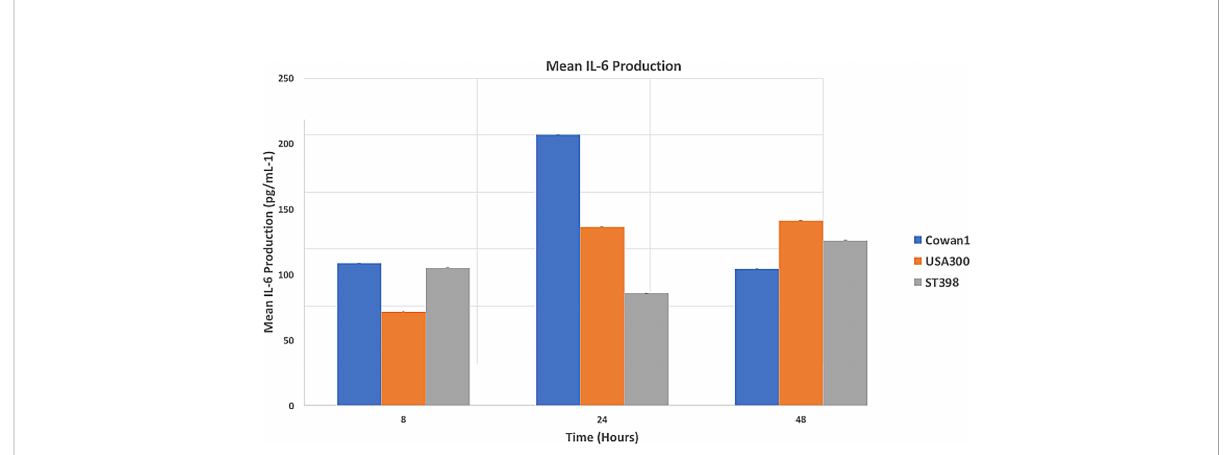
FIGURE 2 Mean IL-6 Production. MC3T3-E1 cells were inoculated with SA ST398, USA300 or Cowan1. Cowan1 showed an initial strong in fl ammatory response that lessened at 48 hours. USA300 became stronger over time. ST398 showed an ebb followed by an increase in in fl ammatory response. IL-6 expression by Cowan1 at 24 hours was signi fi cantly greater than IL-6 expression at 24 hours by ST398. No other signi fi cant differences were detected.